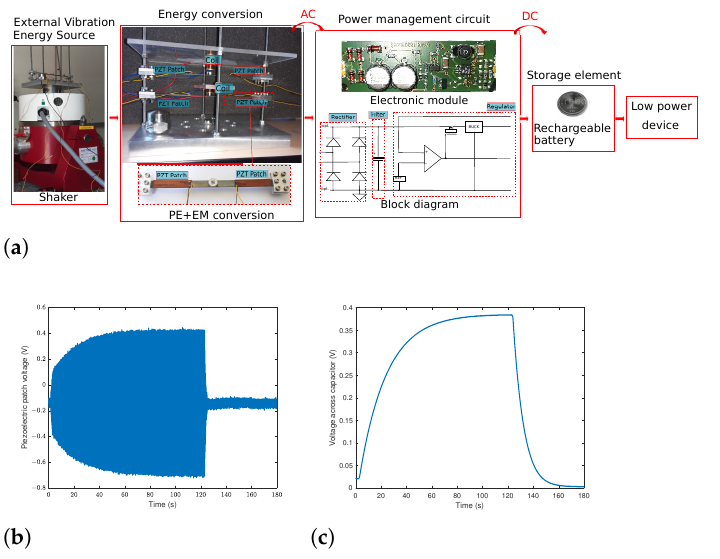
Figure 6. ( a ) Energy acquisition and storage circuit diagram of the HVEH output harvested electrical energy; ( b ) voltage of the piezoelectric patch; ( c ) voltage across a 100 µ F capacitor. The results of this study have to be seen in light of some limitations. The first is the storage of the output energy of the PE and EM elements. In this article, the energy is